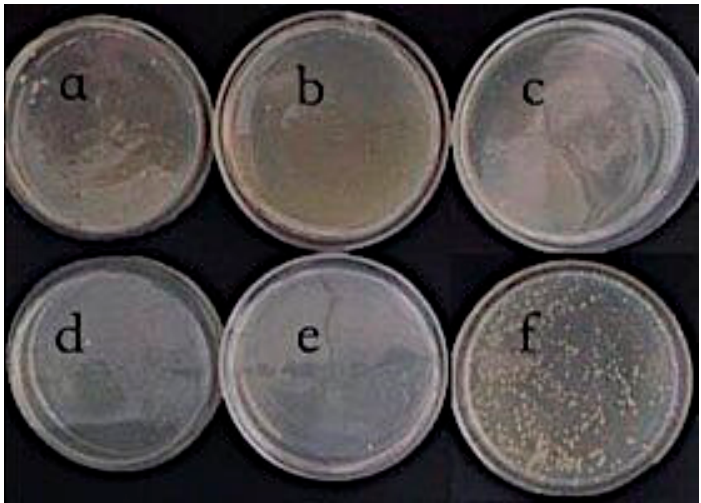
Figure 4. Photographs of antibacterial activity of CS/Gr modified bamboo fiber fabrics (CGBFs). ( a ) C1G1; ( b ) C1G2; ( c ) C1G3; ( d ) C1G4; ( e ) C1G5; and ( f ) control sample.